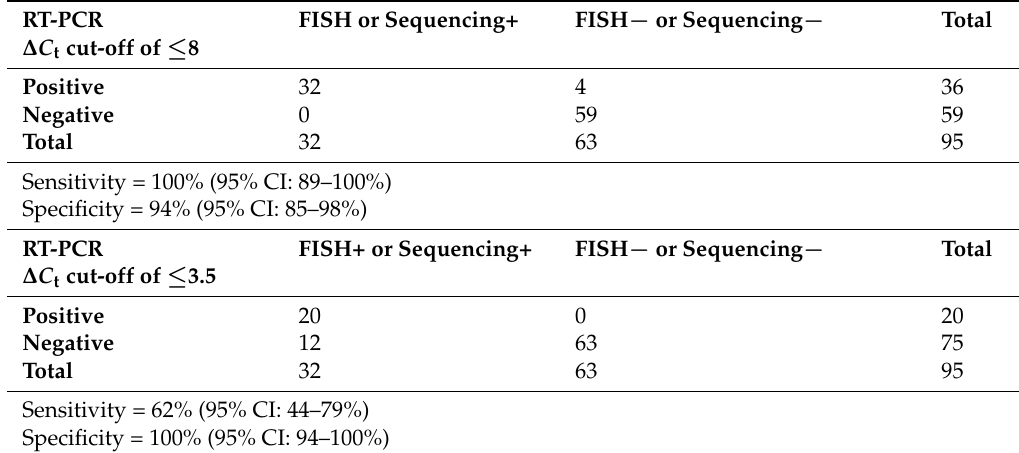
Table 4. Sensitivity and specificity of RT-PCR using ∆ C t ≤ 8 and ∆ C t ≤ 3.5 with FISH plus sequencing as the reference standard for detecting ALK